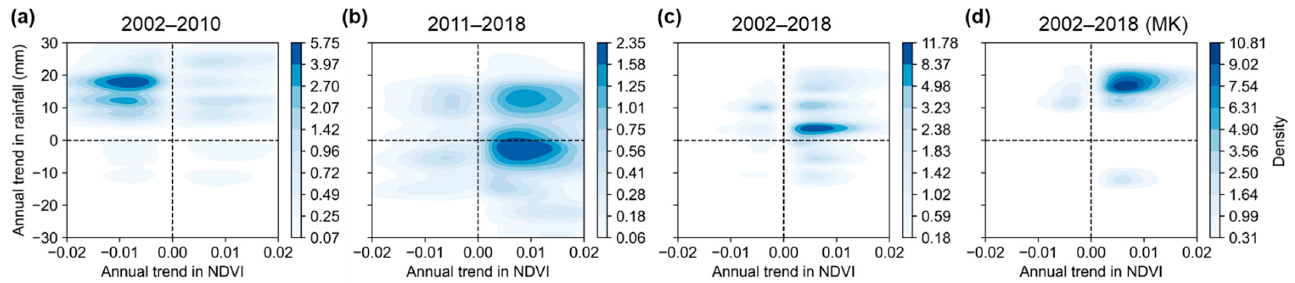
Figure 3. Spatial agreement of all annual rainfall trends and significant NDVI trends (p<0.01) as density plots for the total study area for ( a ) the period 2002–2010, ( b ) 2011–2018 and ( c ) 2002–2018, and for ( d ) 2002–2018 with significant rainfall trends (p<0.05).